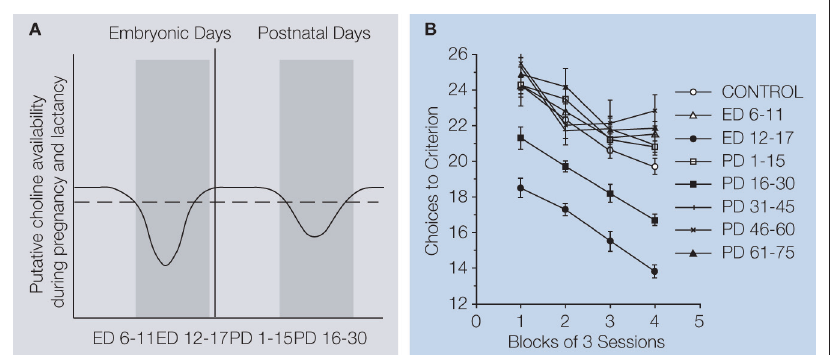
Figure 1 | (A) Schematic representation of two critical periods in which choline deficiency is naturally induced by choline demands imposed by brain development during pregnancy and lactation (Dashed line represents the choline required for optimal rat brain development). The work of Meck et al. (2008) showed that choline supplementation either during Embryonic Days, ED 12–17 or Postnatal Days, PD 16–30 inoculates against the memory decline normally observed in aged rats. (B) Behavioral performance of old rats trained in a spatial memory task as a function of choline supplementation during different developmental periods. Rats that had choline supplemented in ED 12–17 or PD 16–30 solved the 12-radial-arm maze in fewer choices than the counterparts that did not receive choline (control) or received it in other time